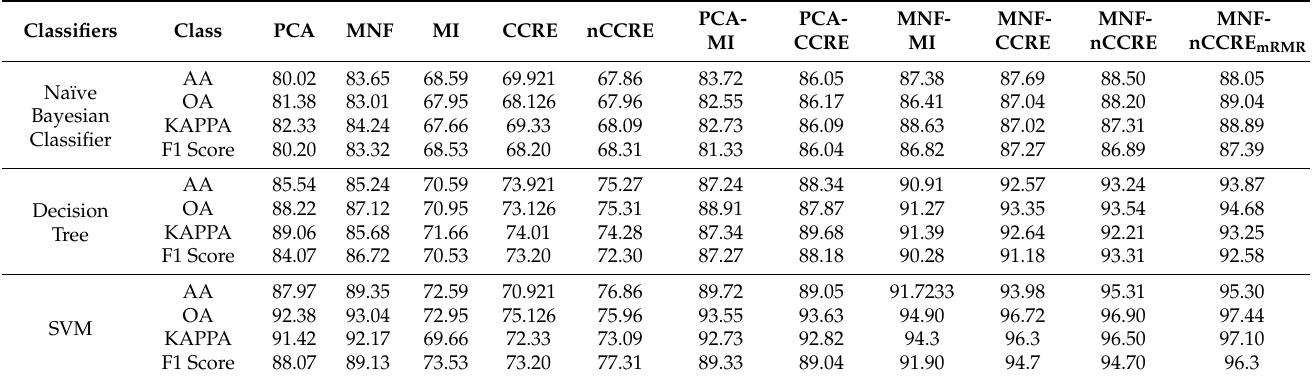
Table 13. Classification performance measure (%) on the AVIRIS IP HSI for different dimension reduction methods and classification methods.